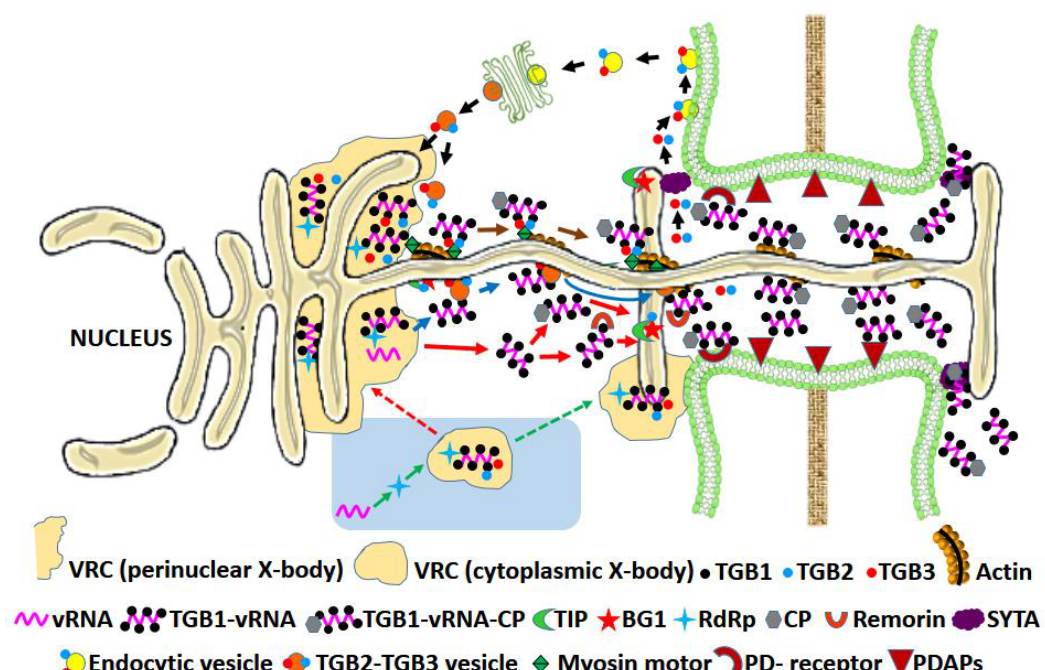
Figure 3. Model for TGB-mediated movement of PVX: The TGB1 organizes the ‘X-body’ (protective center of virus replication and assembly) and recruits TGB2 and TGB3 to it. TGB2 bridges the RdRp/dsRNA-TGBp3 interaction in the X-body. The vRNA in the X body replicates and forms VRC with ribosomes and viral RdRp [9]. The TGB1 alone or with CP binds to the vRNA at the VRC to form a vRNP complex (TGB1-vRNA/TGB1-vRNA-CP) that either directly reaches PD (orange arrows) or binds to the TGB2 and TGB3-associated vesicles and reaches PD along the ER through actin and myosin motor proteins guided by TGB3 (blue arrows) [8,17,129]. Alternatively, the VRC can be delivered to PD by TGB2 and TGB3 without vesicles (brown arrows). TGB2 facilitates the VRC fusion to PD. TGB1 and TGB2 perform PD-gating by interacting with remorin and β -1,3-glucanase-associated host factor TIP1, respectively, causing callose reduction. Subsequently, the vRNP complex is delivered to the adjacent cell leaving back TGB2 and TGB3 for recycling via endocytic pathway (black arrows) [18]. According to a recent alternative model (blue background) [93], the vRNA binds to RdRp in the cytoplasm forming the core replication unit later joined by TGB1, TGB2, TGB3 and CP to form a “cytoplasmic X-body”, which either joins the ER-associated perinuclear X-body (red dashed arrow) or directly reach the PD through TGB3 guided movement forming cap like complexes at PD (green dashed arrow). Abbreviations: BG1— β -1,3-glucanases; CP—coat protein; PDAPs— PD-associated proteins; RdRp—RNA-dependent RNA polymerase; TGB—triple gene block;